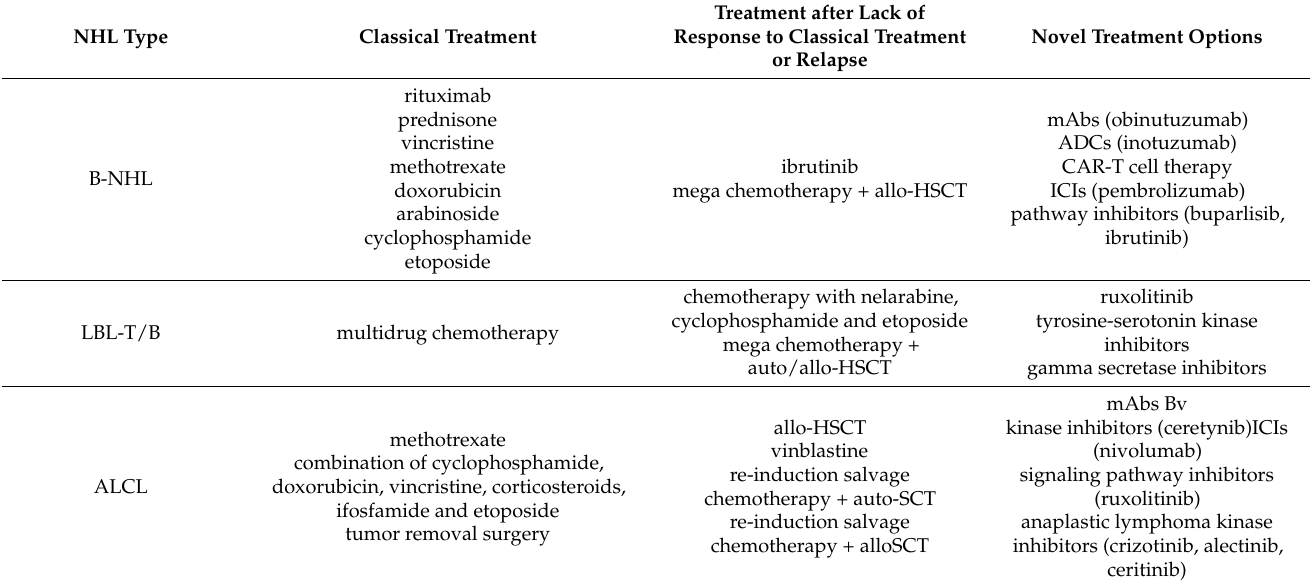
Table 2. Treatment of different types of NHL in children